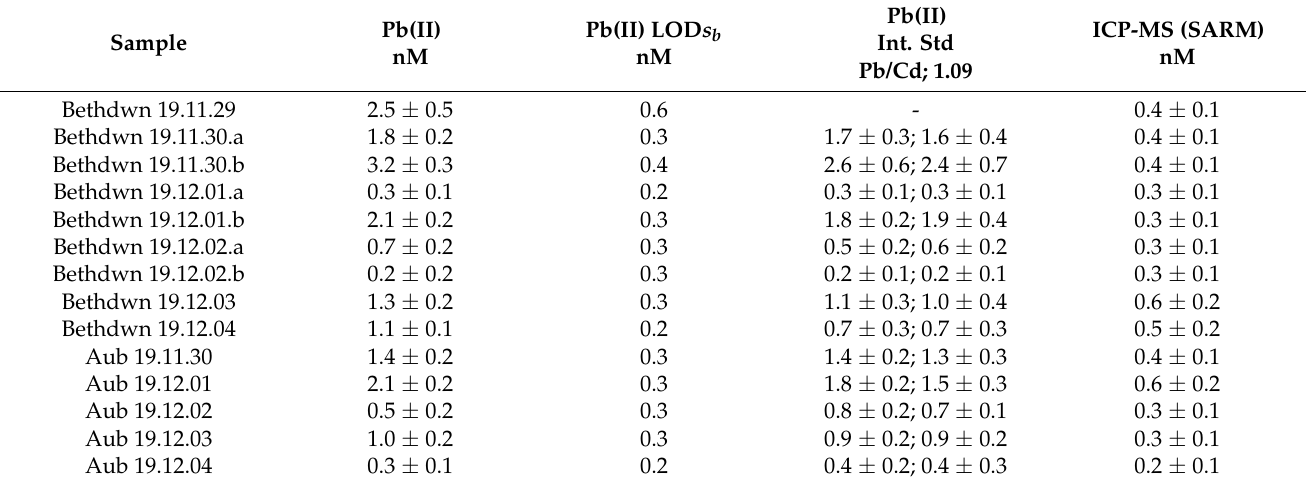
Table 6. Pb(II) results obtained for the standard additions and deposition times of 90 s in the unfiltered river samples at pH 3.5, and their comparison with the ICP-MS results obtained in the strongly acidified samples. a and b written after the sample names refer to replicate